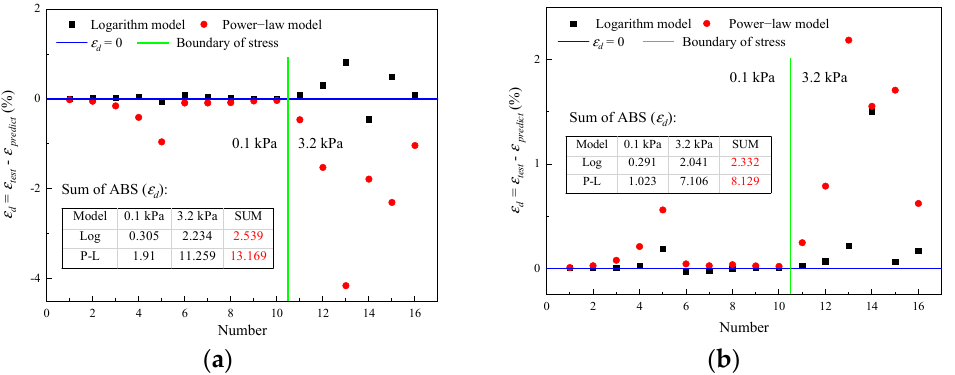
Figure 12. Comparison of prediction effects for initial strain and residual strain: ( a ) Prediction of ε c ; ( b ) prediction of ε r